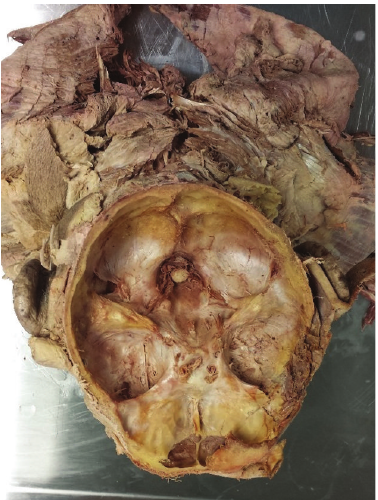
Figure 4: Superior view showing the reduction of space of the right side due to the shift of internal occipital protuberance to the right compared to the left side of the